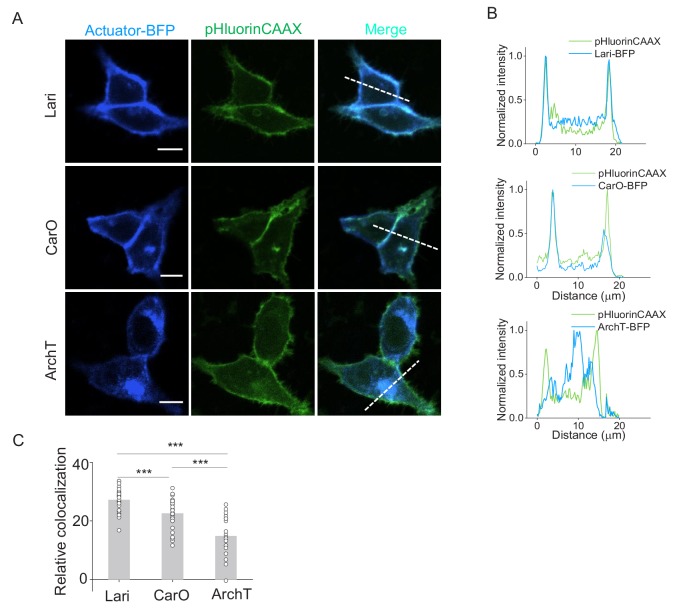
Membrane traffic performance of two proton-pumps compared with ArchT.(A) Confocal images showing the expression of two new proton pumps besides ArchT in HEK293T cells. Proton pumps were fused with BFP at the C-terminus and co-expressed with pHluorinCAAX. (B) The normalized line-scanning plots of the fluorescence signals in both blue and green channels. (C) Relative colocalization were measured by Pearson’s colocalization ratios of the Autuator-BFP according to pHluorinCAAX (n = 28 for each protein). The scale bars represent 10 μm. ***p<0.001.